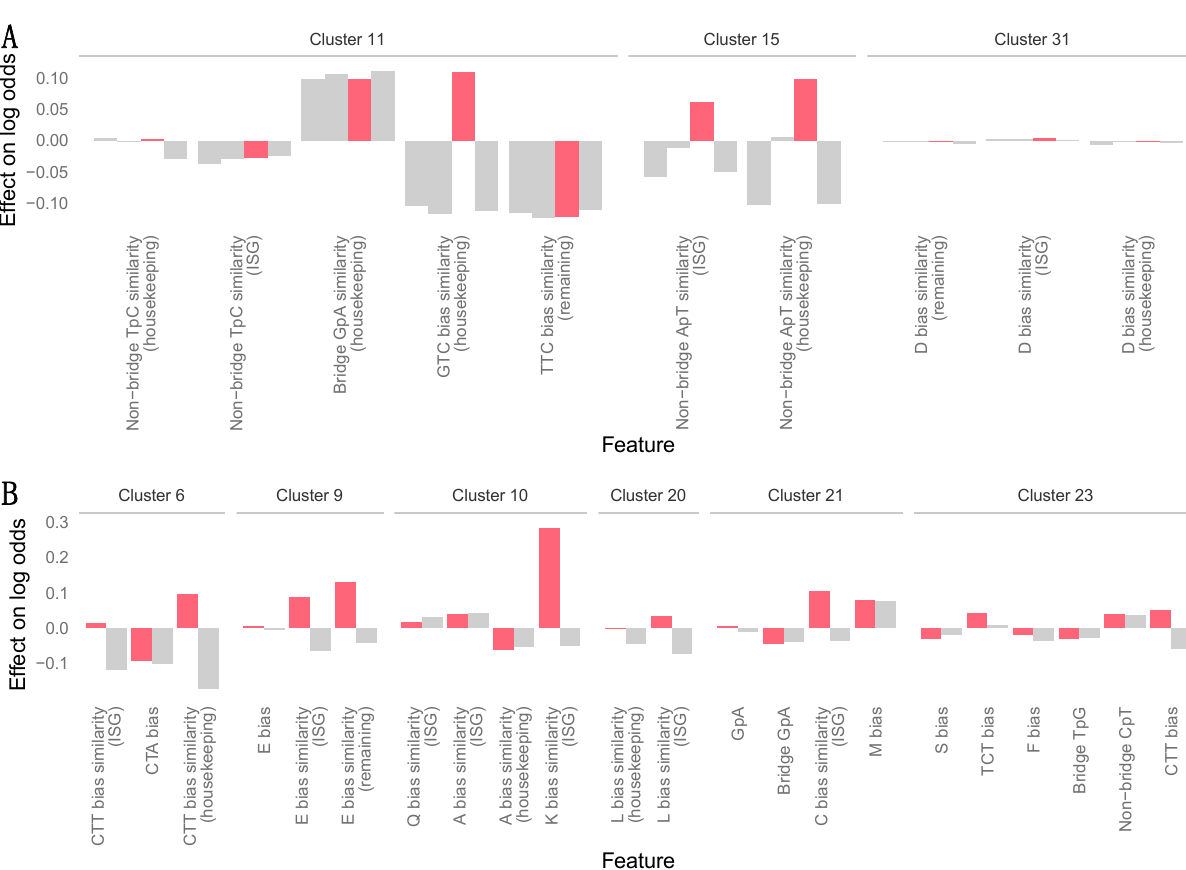
Figure 4. Compositional features influencing predictions of the GCB model. Features are grouped in discrete clusters of correlated features. ( A ) Effects of individual features making up key clusters which explain the difference in priority between AYA14_F_HEV (red) and other HEVs (grey). ( B ) Individual feature effects for key clusters explaining the differences in scores assigned to CUS8_F_PicoV (red) and LMA6_F_PicoV (grey), the two Parechovirus -like Picornaviridae for which near complete genomes were available. Feature clusters were taken from Mollentze et al. [15], and the overall influence of each cluster on predictions for a given virus was calculated by summing effect sizes across all features in the cluster (see Figure S8). Each illustrated cluster increased the predicted log odds for the virus highlighted in red (the highest-ranked virus in each group) and had an effect on this virus which was more than five-fold larger than its effect on any other closely related virus. Features containing the word “similarity” measure compositional similarity between each virus and a set of human genes (interferon stimulated genes (ISG), non-ISG housekeeping genes, or remaining genes). All other features describe virus genome composition directly. Names starting with a single letter (e.g., “D bias”) describe amino acid usage biases, names with three capital letters (e.g., “GTC bias”) describe codon usage biases, and the remaining features (e.g., “TpC” bias) describe over- or under-representation of specific dinucleotides, measured either across the whole genome or specifically at codon bridge or non-bridge positions.